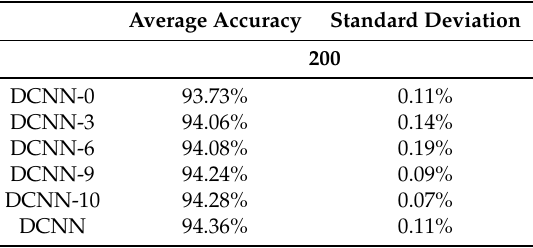
Table 13. Average accuracy scores and their standard deviation of the original train/test split of the WISDM dataset for varying numbers of statistical features.